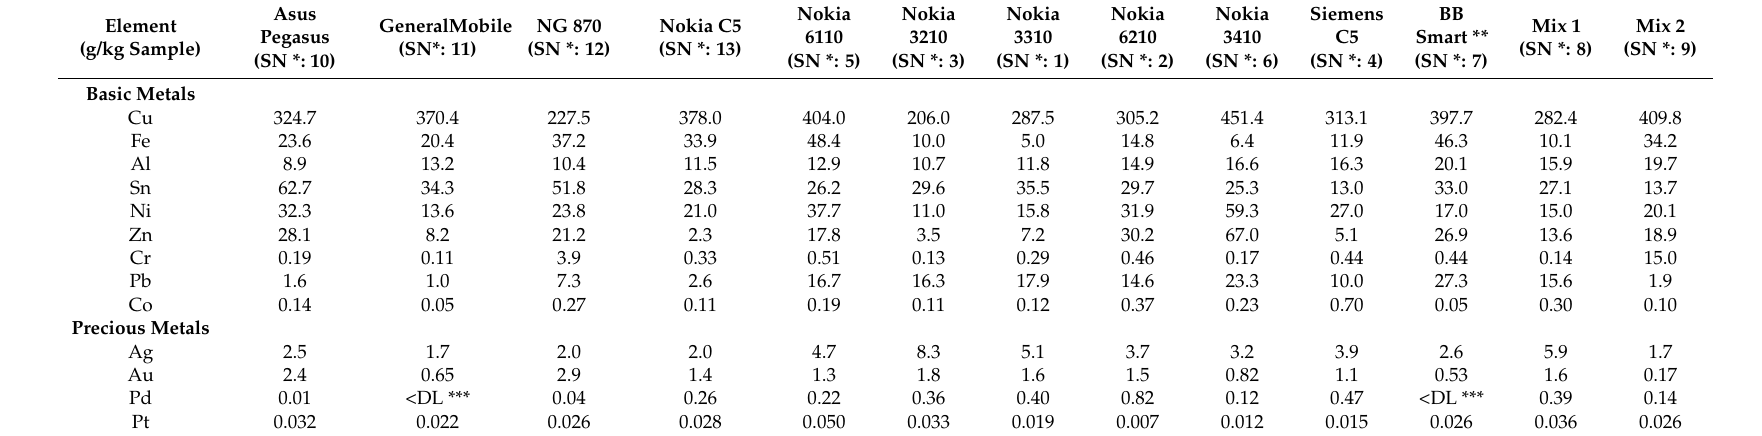
Table 6. Mean concentrations of metals in the PCBs of mobile phone